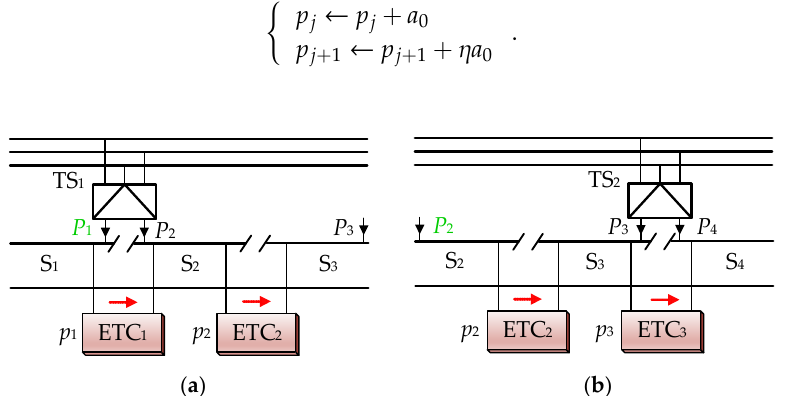
Figure 8. When j ≤ 2, the regenerative braking power is transferred by two adjacent converters: ( a ) j = 1 and ( b ) j = 2.